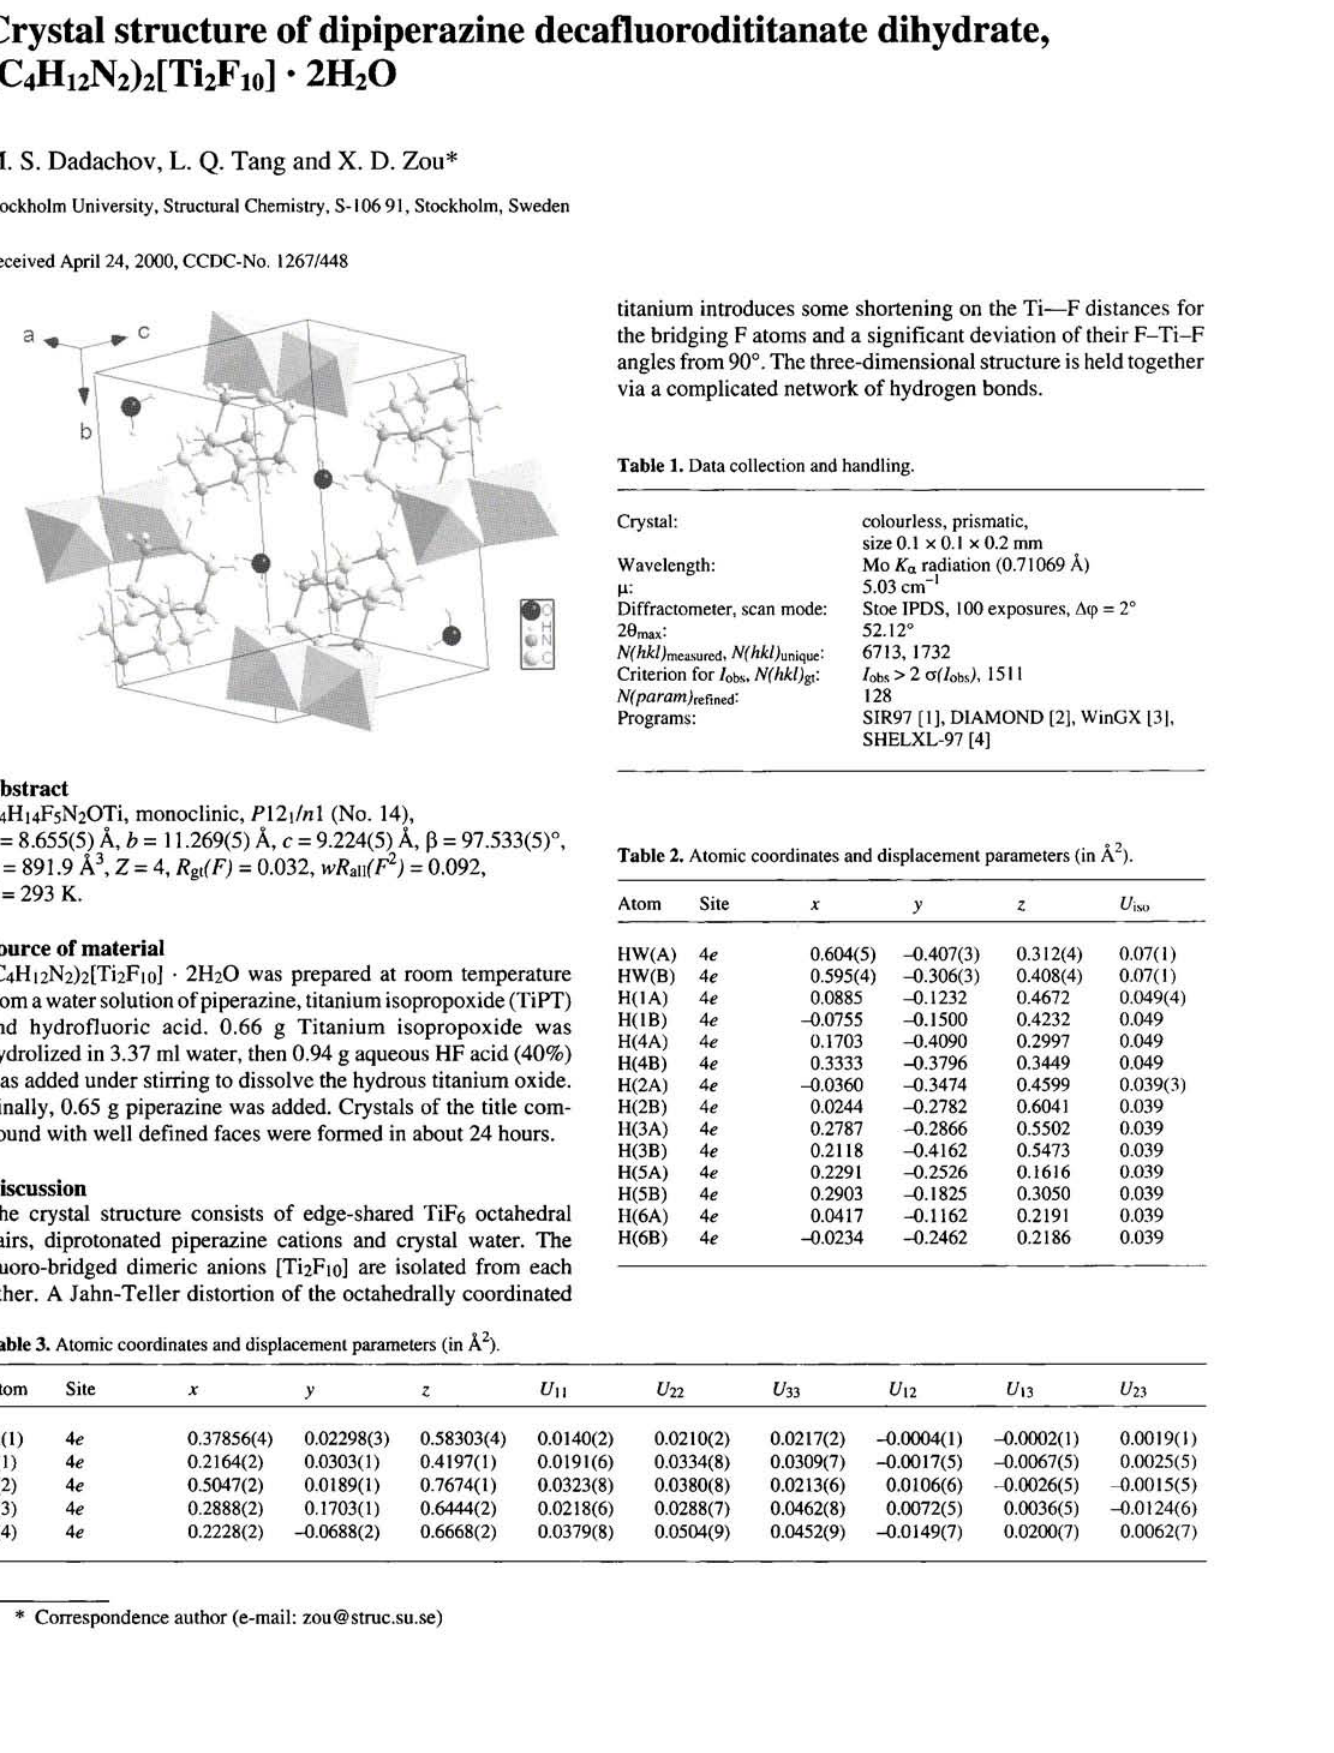
Table 1. Data collection and handling.